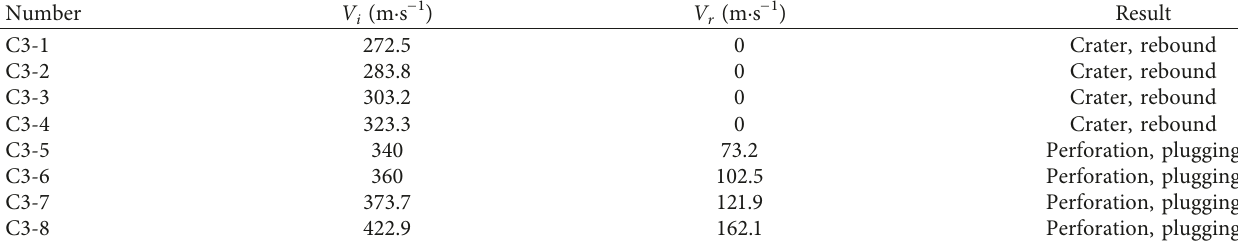
Table 7: Numerical simulation result of Case 3.